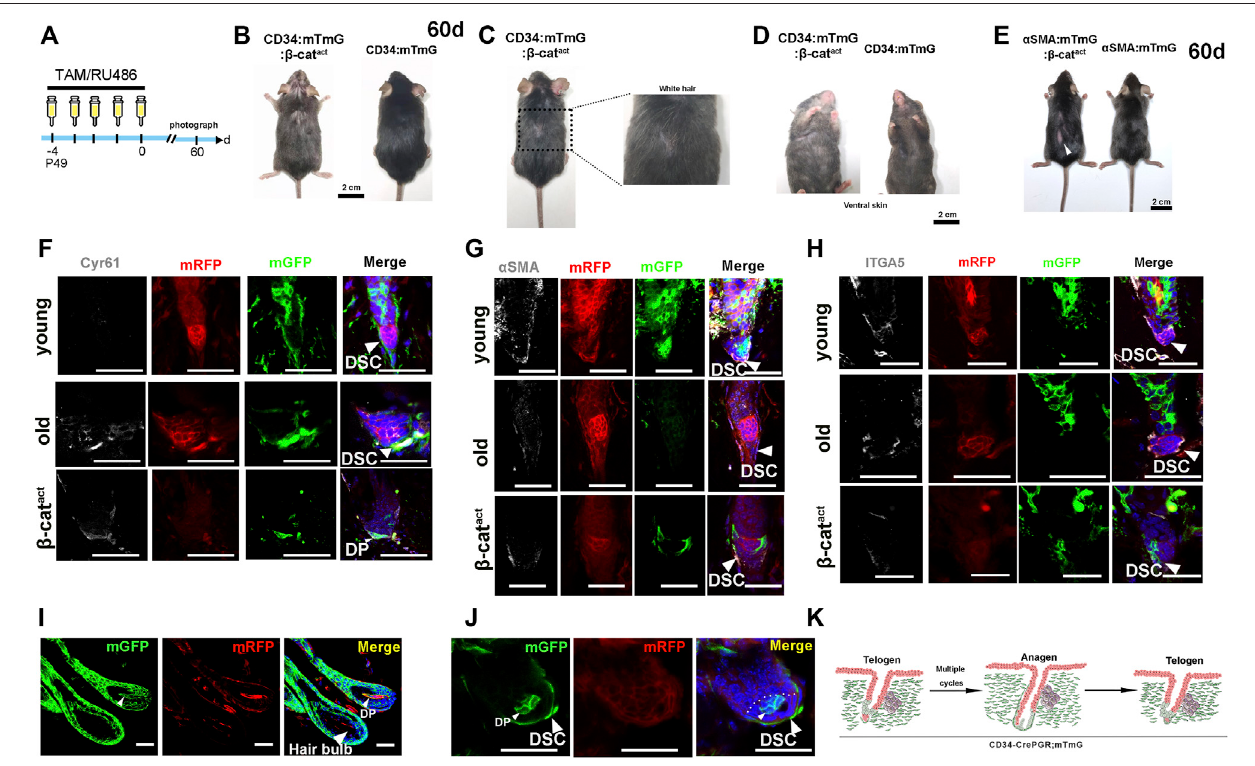
FIGURE4| Activation of β -catenin leadstoHFmesenchymalsenescenceand reduction ofhfDSC progenitor pool. (A) SchematicdepictingthetimelineofRU486/ tamoxifen injections and analysis. (B) Hair coat of CD34:mTmG: β -cat act (left panel) and mTmG: β -cat act (right panel) mice photographed at 60 days after RU486 injections. (C) CD34:mTmG: β -cat act mice exhibited signi fi cantly grayer hair coats. (D) Ventral view of CD34:mTmG: β -cat act mice (left panel) and control mTmG: β -cat act littermates (right panel). (E) Hair coats of pairs of α SMA:mTmG: β -cat act (left panel) and mTmG: β -cat act (right panel) mice were photographed 60 days after tamoxifen injections. (F,G) Immunostaining for Cyr61 (F) , α SMA (G) and ITGA5 (H) in skin tissues from young (upper panel) and old CD34:mTmG mice (middle panel), and CD34:mTmG: β -cat act mice (lower panel). (I) HFs of 18-month-old CD34:mTmG mice illustrating DP cells above Auber ’ s line replenished by mGFP-labeled cells. (J) Telogen HFs of 18-month-old CD34:mTmG mice showed a signi fi cant increase in lineage-labeled mGFP + cells within DP. (K) Schematic illustration of the CD34 lineage tracing (green) in the HF of CD34:mTmG mice after multiple cycles. Scale bars, 2 cm (B – E) ; 50 μ m (F – K) .